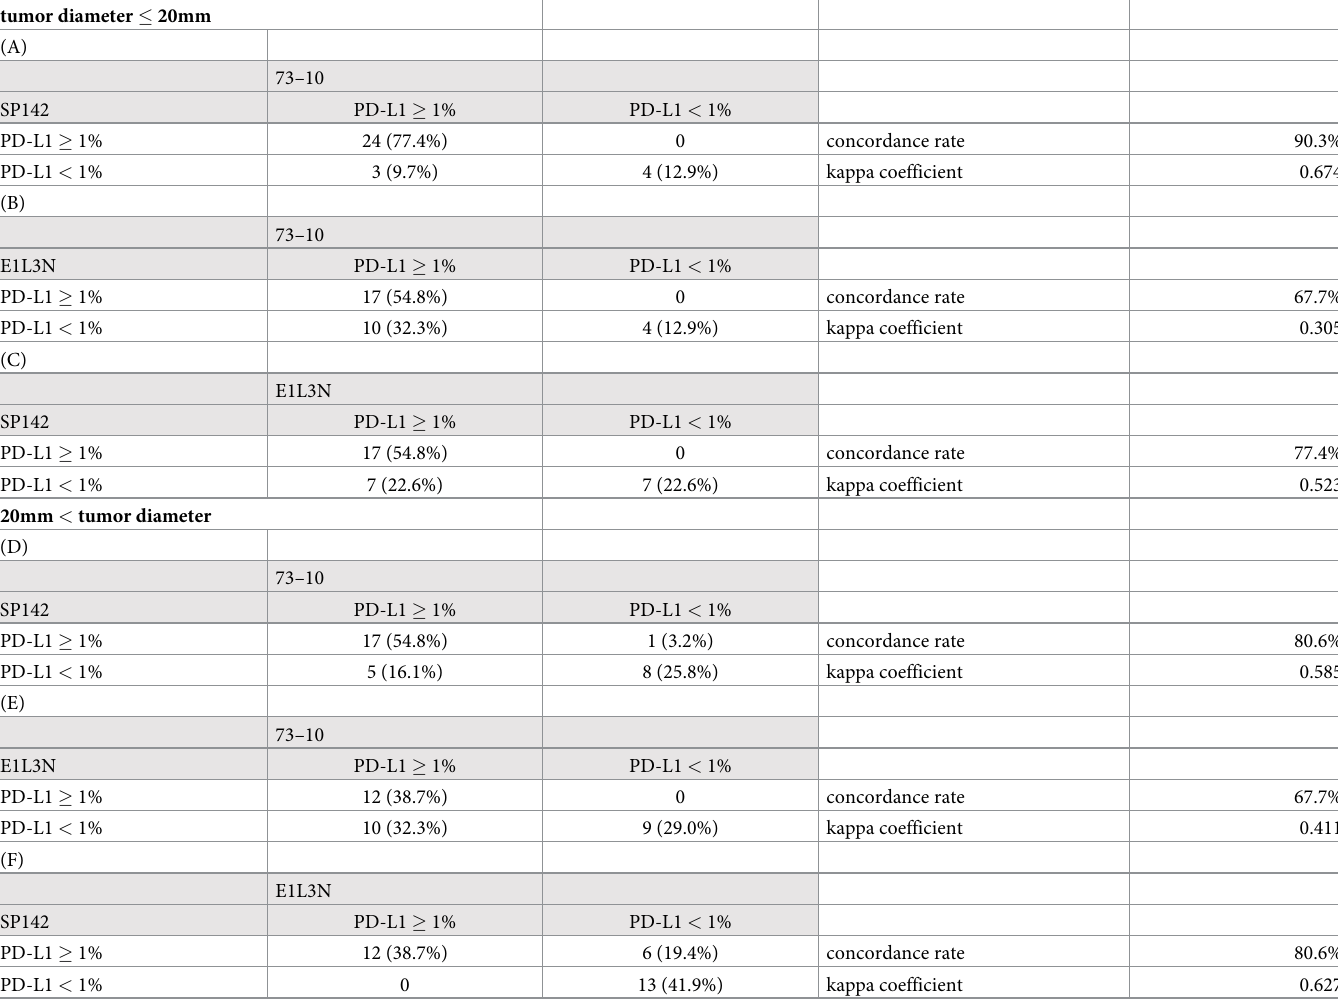
Table 6. Comparison of PD-L1 expression on ICs by 73–10, SP142, and E1L3N assays in tumor diameters. tumor diameter �